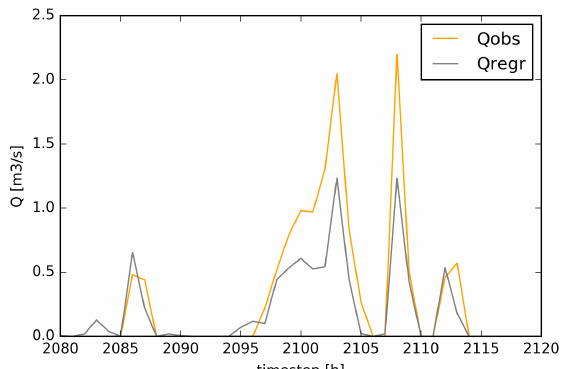
Figure 11. Discharge at outlet for rainfall events in March 2015. Observed discharge in yellow and regressed discharge in grey.